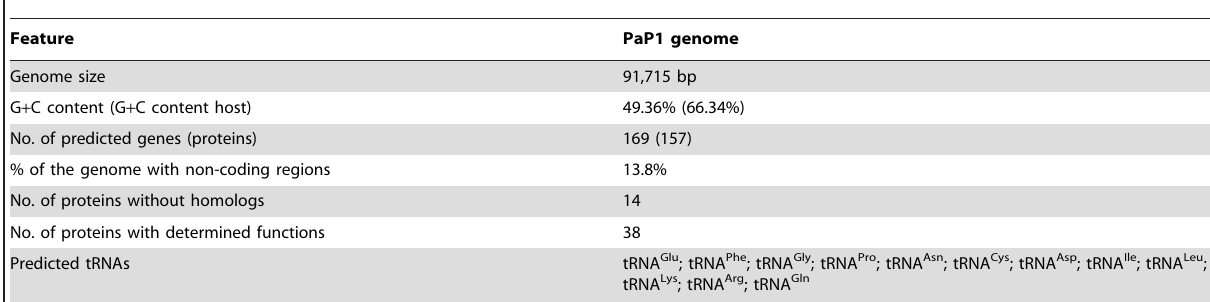
Table 1. General features of the PaP1 genome.